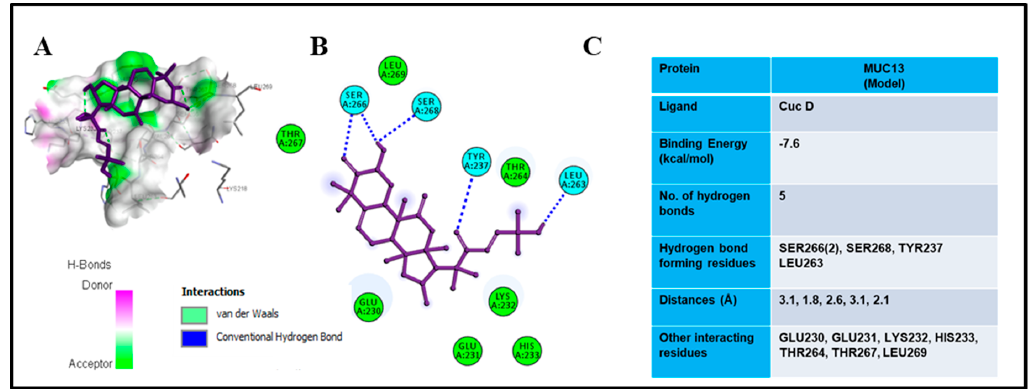
Figure 4. Molecular docking studies of Cuc D with MUC13. Binding view of Cuc D in the catalytic pocket of ( A ) MUC13 shows the hydrogen bond donor-acceptor residues. 2D schematic representations for the docking model of Cuc D with ( B ) MUC13. Dotted lines in different colors show various types of interactions such as hydrogen bonding, charge or polar interactions and van der Waals interactions. Table showing docking score of Cuc D with MUC13 ( C